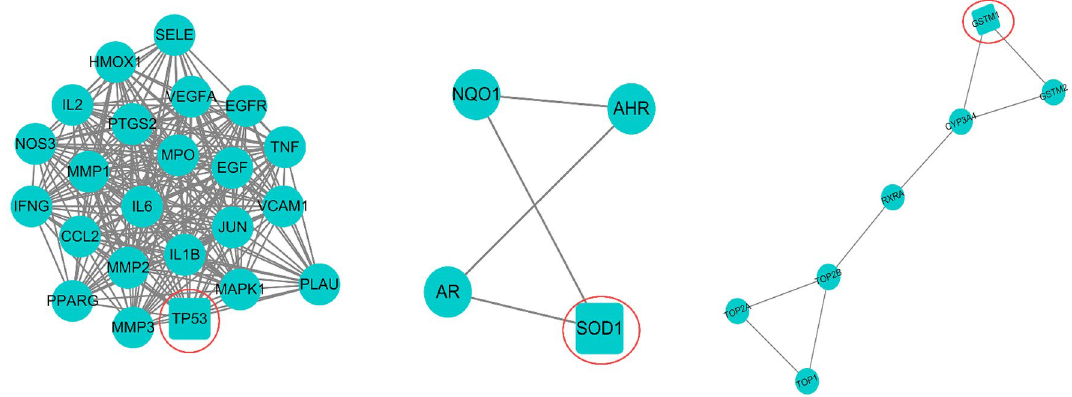
Figure 4. The constructed PPI network was imported into Cytoscape software, and the MCODE module was opened for gene cluster analysis and core target screening. Three gene clusters were obtained. The core gene of each cluster was circled in red.